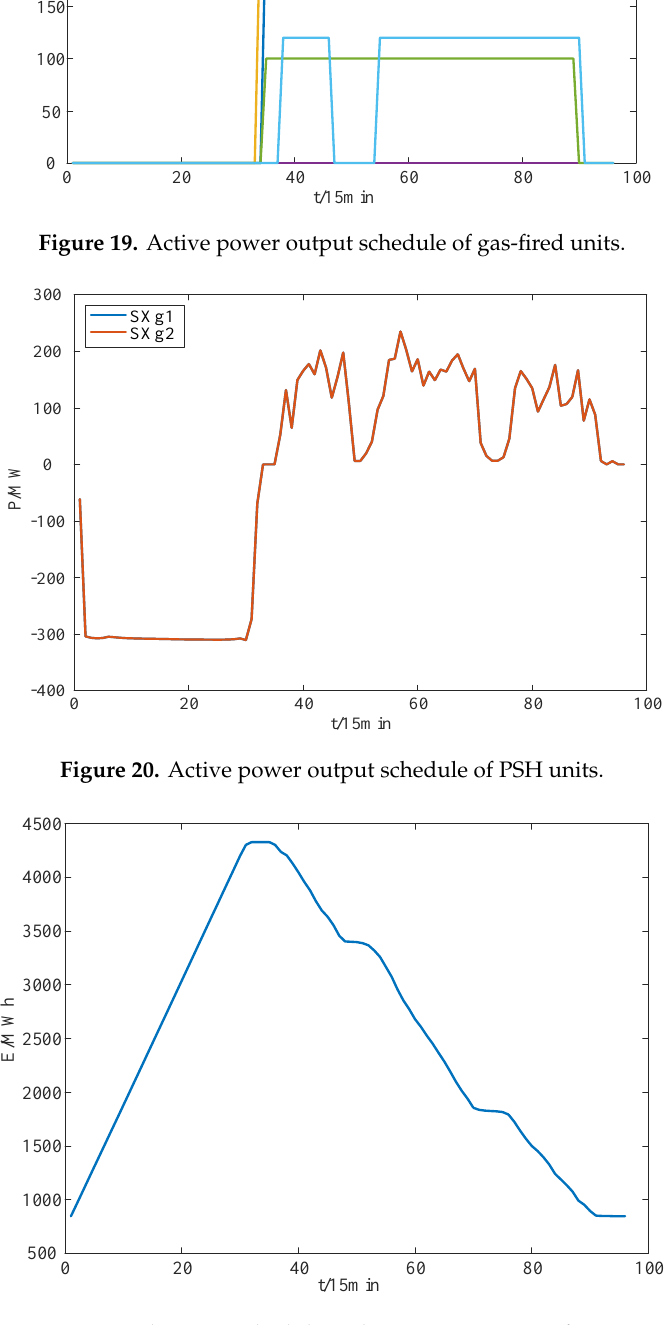
Figure 21. Stored energy schedule in the upper reservoir of PSH units.